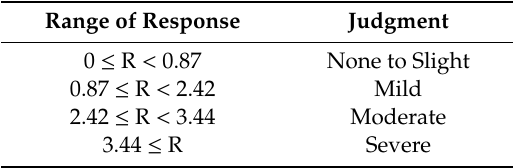
Table 2. Determination criteria for skin primary irritation [21].